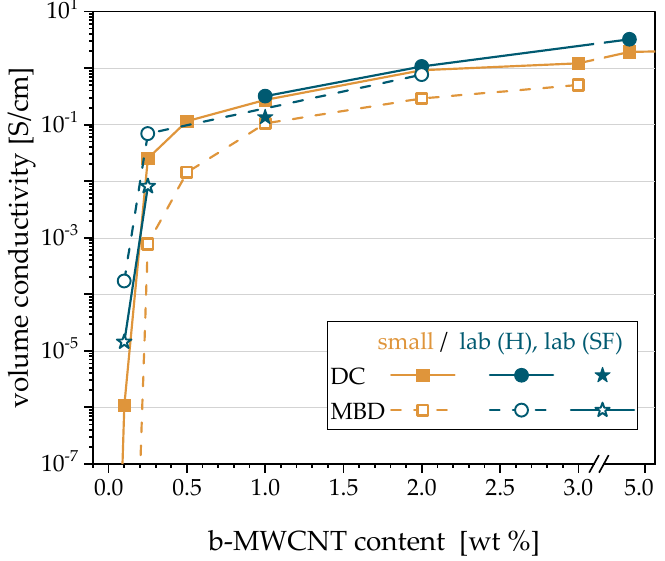
Figure 3. Electrical volume in-plane conductivity of PVDF1 / b-MWCNT composites (compression-molded plates) prepared at small scale or laboratory scale (10 kg / h) and direct compounding (DC) or masterbatch dilution (MBD; small scale from 7.5 wt % to lower contents, lab scale from 5 wt % to 2 wt % and from 2 wt % to 0.1 and 0.25 wt %).